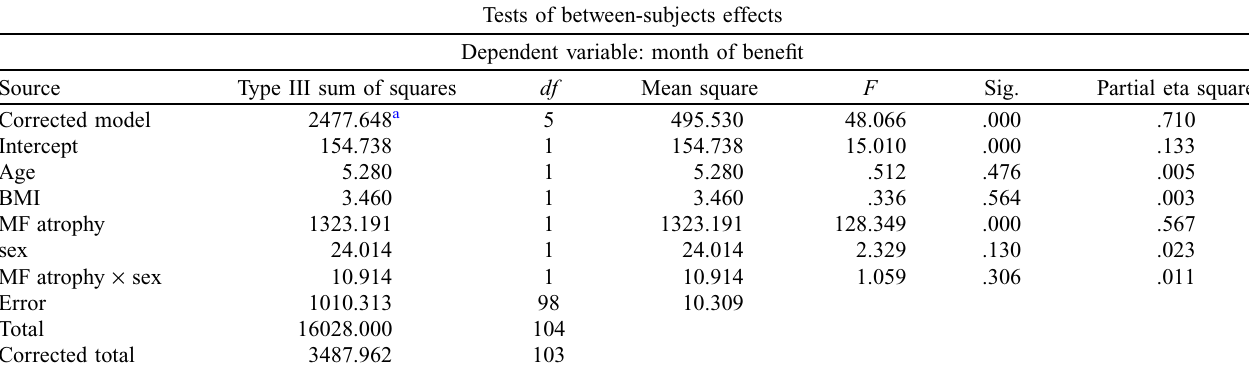
Table 2. Explains the practical significance of each variable on the duration of benefit. Tests of between-subjects effects